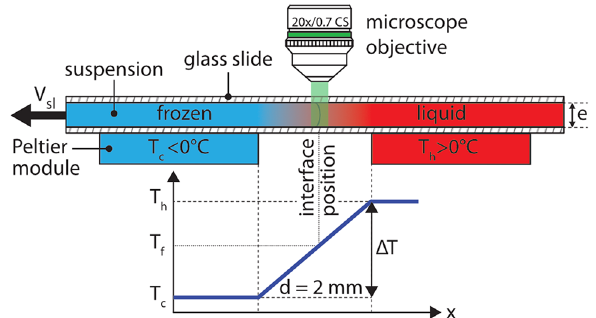
Figure 2. Experimental setup for in situ solidification experiments. A thin Hele-Shaw cell containing the droplets in suspension is pulled at a constant velocity ( V sl ) through a constant temperature gradient ( G ) established by Peltier elements. In steady state, the solidification front is thus at a constant position under the microscope objective. © (2020) S. Tyagi et al. (10.6084/m9.figshare.12046560) CC BY 4.0 license https ://creat iveco mmons .org/licen ses/by/4.0/.